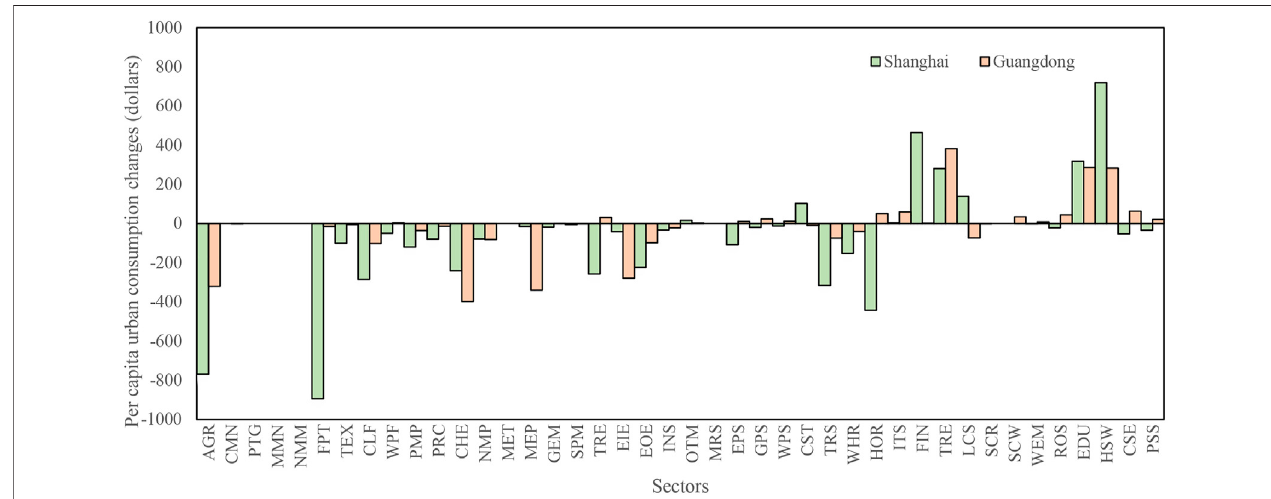
FIGURE 6 | Urban consumption changes during the study period in Shanghai and